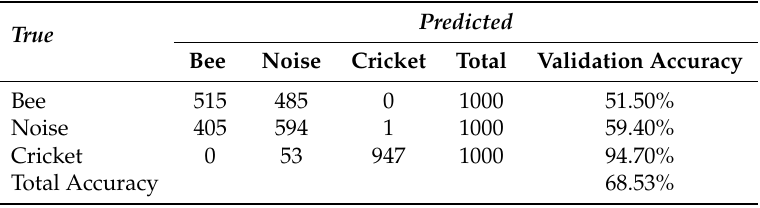
Table 21. Confusion matrix for logistic regression on BUZZ2 validation dataset.